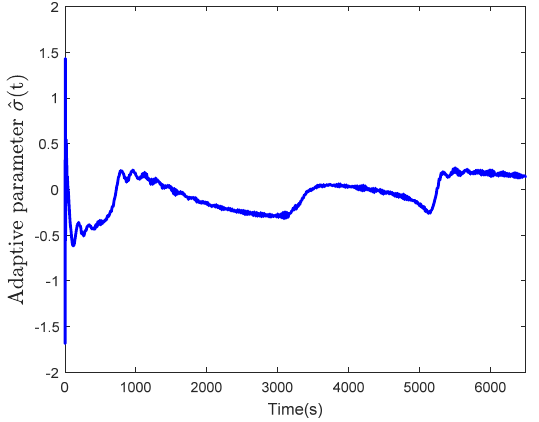
Figure 7. Adaptive parameter ˆ σ ( t )